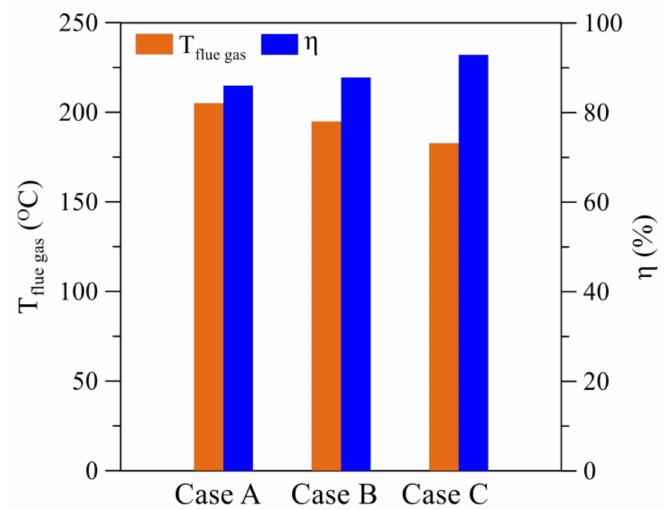
Figure 11. Boiler efficiencies and flue gas temperatures under different operating conditions. Case A: firing HFO without cleaning the boiler tubes; Case B: firing emulsified HFO with 20 vol% water without cleaning the boiler tubes; Case C: firing emulsified HFO with 20 vol % water after cleaning the boiler